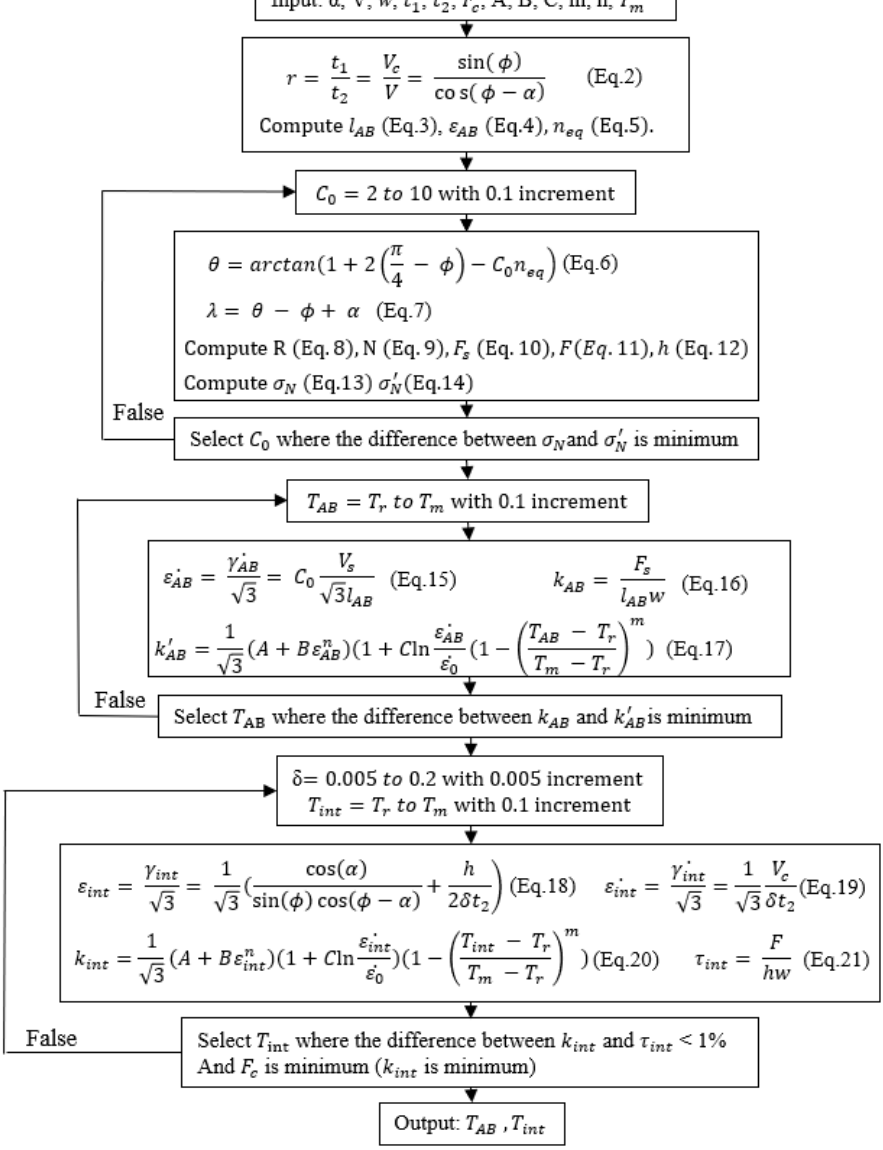
Figure 5. Flowchart for the algorithm of temperature prediction based on the Johnson–Cook (J–C) model and the chip formation model.